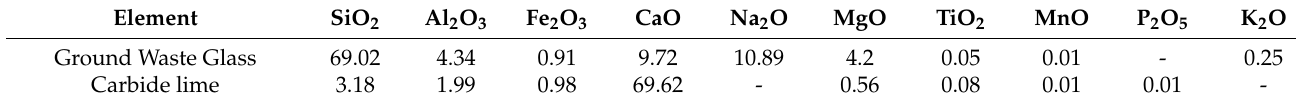
Figure 1. Particle size distribution of ground waste glass, carbide lime and Osorio sand . Table 2. Composition of the ground waste glass and carbide lime (wt %). Table 2. Composition of the ground waste glass and carbide lime (wt %) .